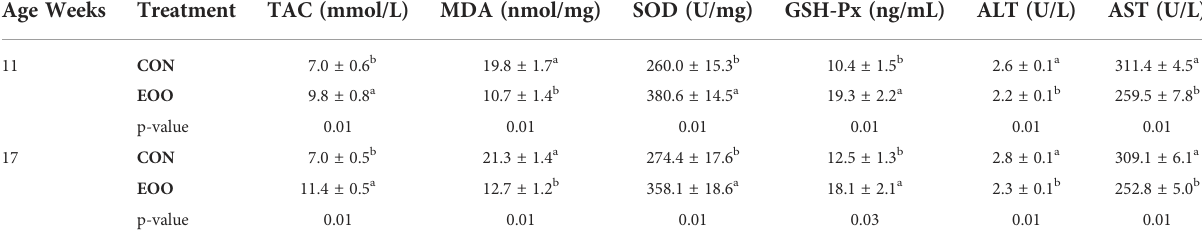
TABLE 7 Serum antioxidant capacity parameters of pullets at 11 and 17 weeks of age.